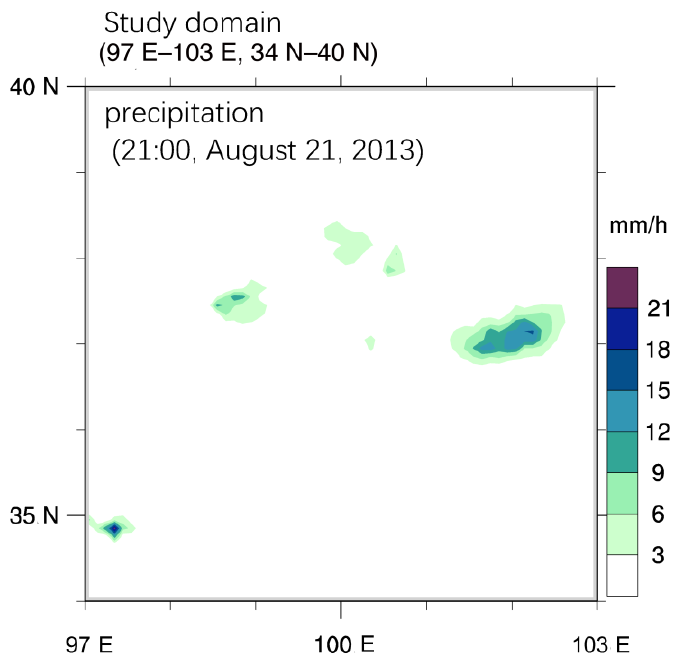
Figure A1. Hourly spatial precipitation at 21:00 on 21 August 2013 over the study domain in Northeastern Tibetan Plateau. The domain averaged precipitation is 0.27 mm / h, while the maximum precipitation is 22.08 mm / h. It is noted that gridpoints (here 360 total gridpoints) with and without precipitation were all considered for the domain average.